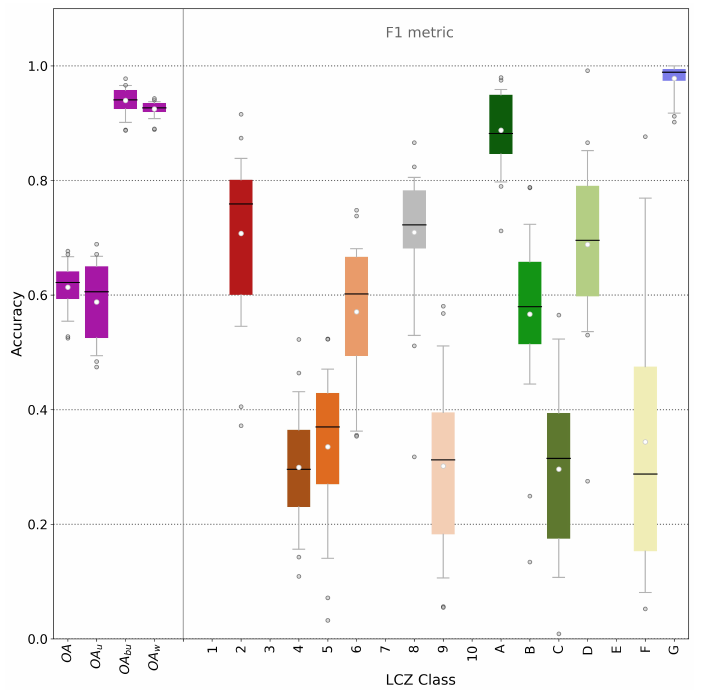
Figure 9. Boxplot accuracy of the LCZ generator map for the previous WUDAPT training areas of Berlin; data from [40] (see also